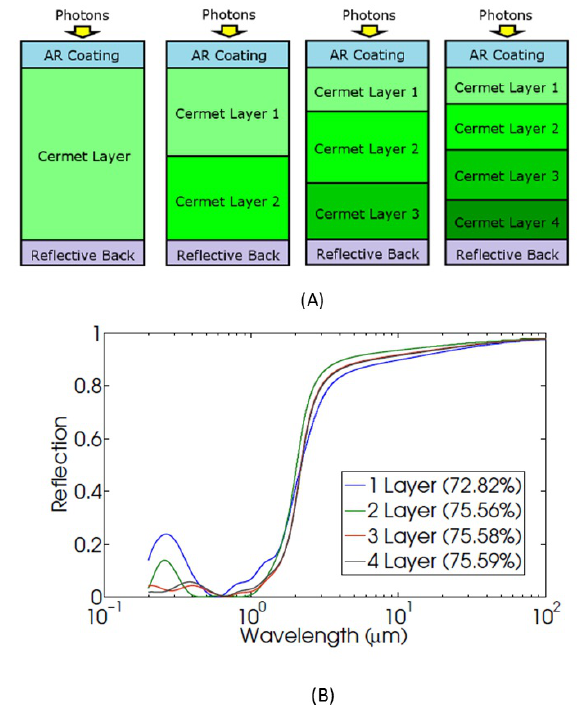
Fig. 3. Cermet selective solar absorber. (A) Schematic drawing of the cross-section of multilayer W cermets. (B) Simulated reflec- tion spectra of optimized multilayer W cermets. Panels (A) and (B) adapted with permission from [45]. © 2011 Optical Society of Amer- ica.